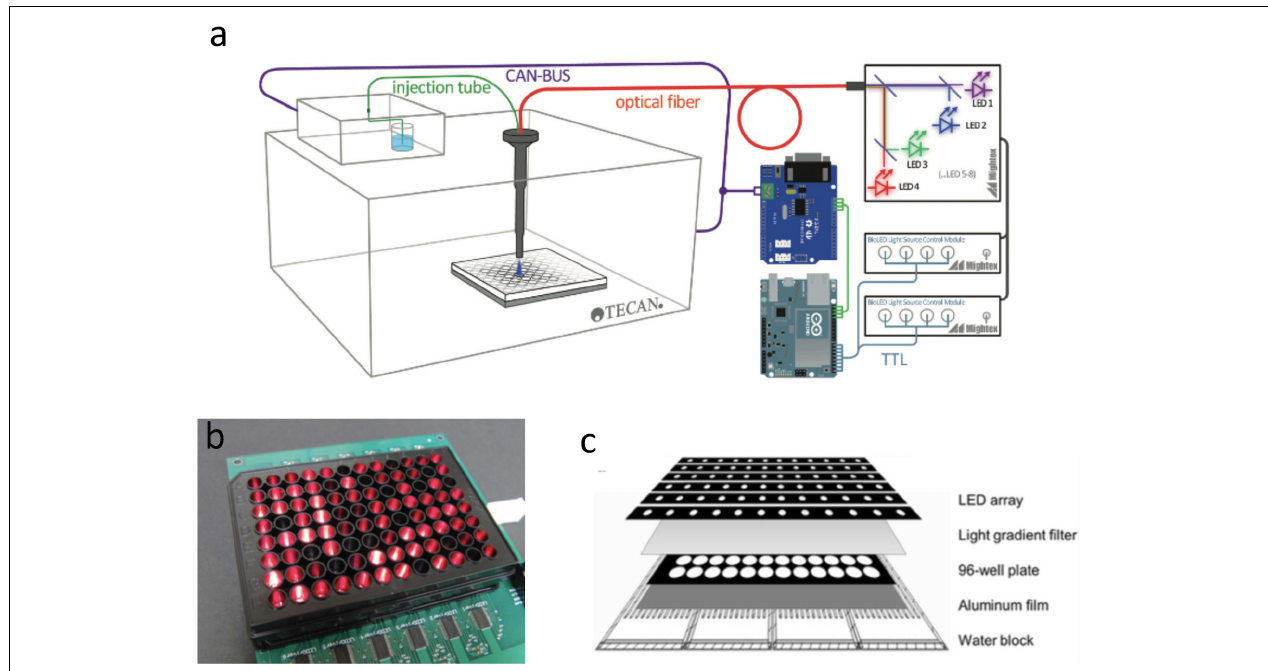
FIGURE 2 | Microplate photobioreactors. (a) Add-on illumination path for a Tecan plate reader (Richter et al., 2015). © Royal Society of Chemistry. Reproduced with permission. (b) An assembled optical microplate for microalgae cultivation (Chen et al., 2012). © Royal Society of Chemistry. Reproduced with permission. (c) Layered assembly for the “Photobiobox,” a high-throughput solution for microalgal screening and culture optimization (Heo et al., 2015). © Elsevier Ltd. Reproduced with